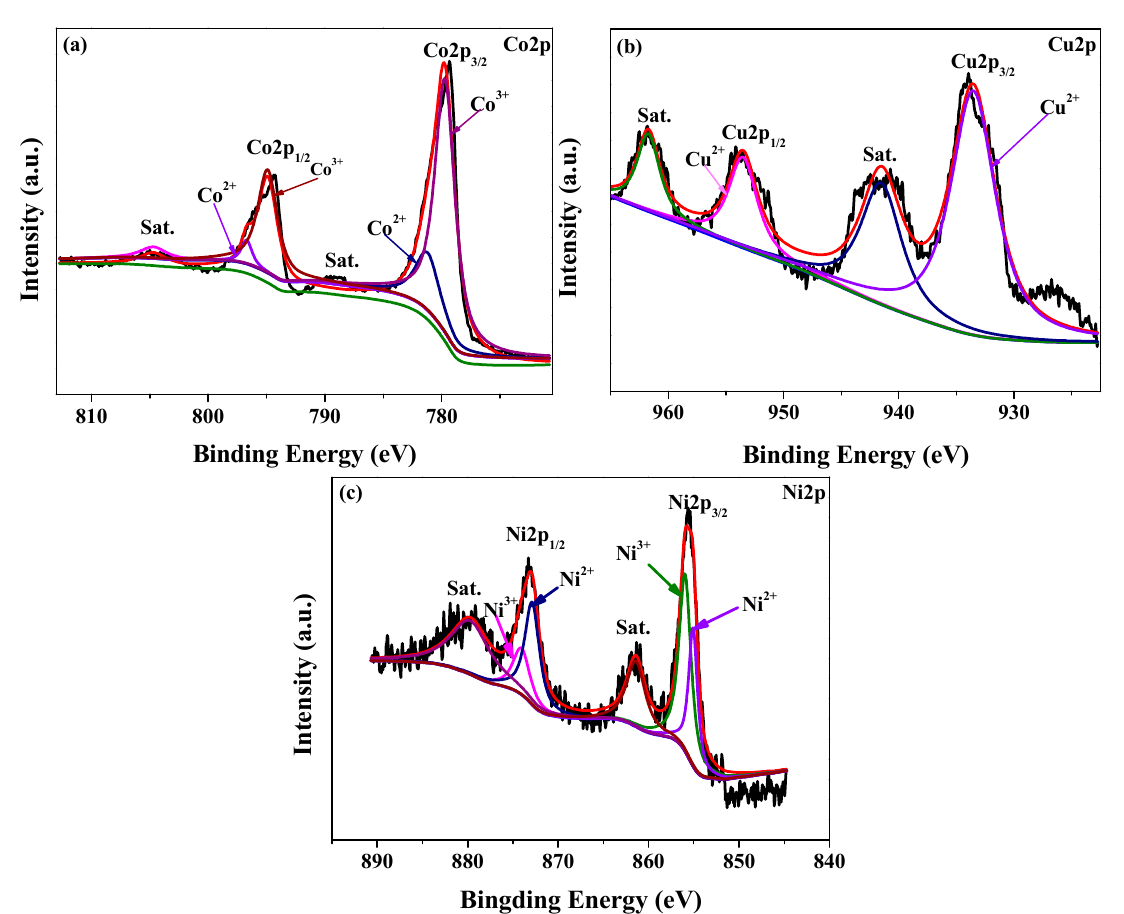
Figure 5. XPS spectra of the Ni 0.5 Cu 0.5 Co 2 O 4 nanoplatelets: Co2p (a), Cu2p(b) and Ni 2p(c).